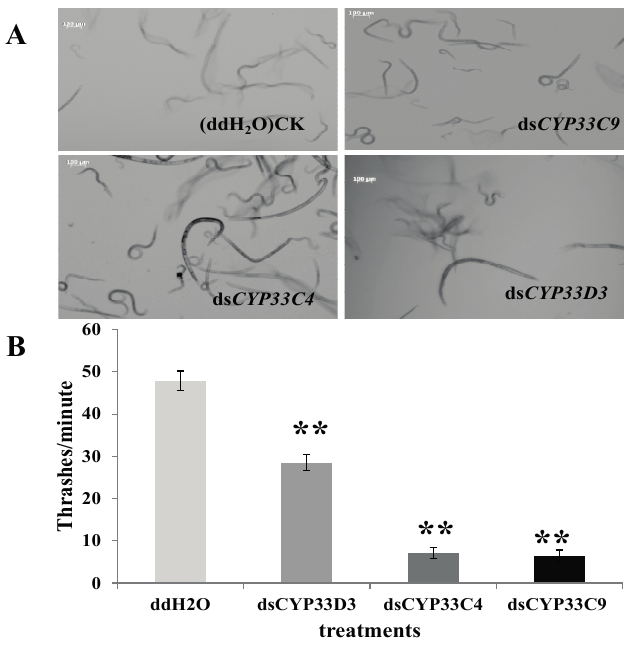
Figure 4. Effect of RNAi to vitality of B. xylophilus . ( A ) Morphology and movement of B. xylophlilus after soaking in dsRNA (ds CYP33C9 , ds CYP33C4 and ds CYP33D3 ) for 48 h. All the pictures were taken under normal conditions (in proper focus). Scale bars = 100 µm; ( B ) Thrashing rate of B. xylophilus after soaking in dsRNA. B. xylophilus soaked in ddH 2 O were used as control. Data represent mean values ± SD from three independent experiments. Bars show standard deviations of the mean. Asterisks on top of the bars indicate statistical differences ( ** p < 0.01, Student’s t -test) were found between the dsRNA-treated (ds CYP33C9 , ds CYP33C4 and ds CYP33D3 ) nematodes and